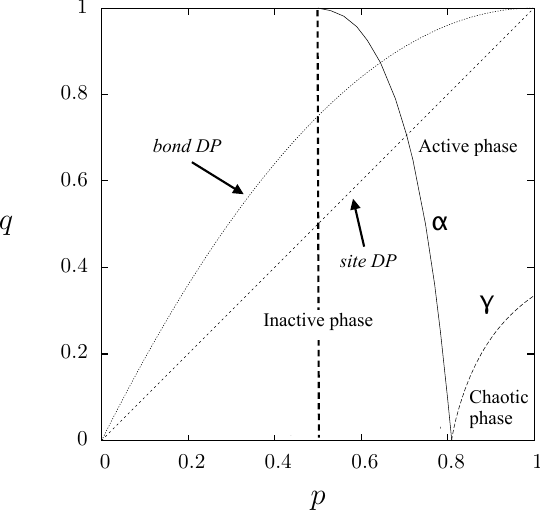
Figure 1. The phase diagram of the DK model, α marks the critical line separating the active and inactive (or absorbing) phase, γ marks the “chaotic” phase near the corner p = 1, q = 0. The simplest mean-field approximation gives p c = 1/2 independently of q